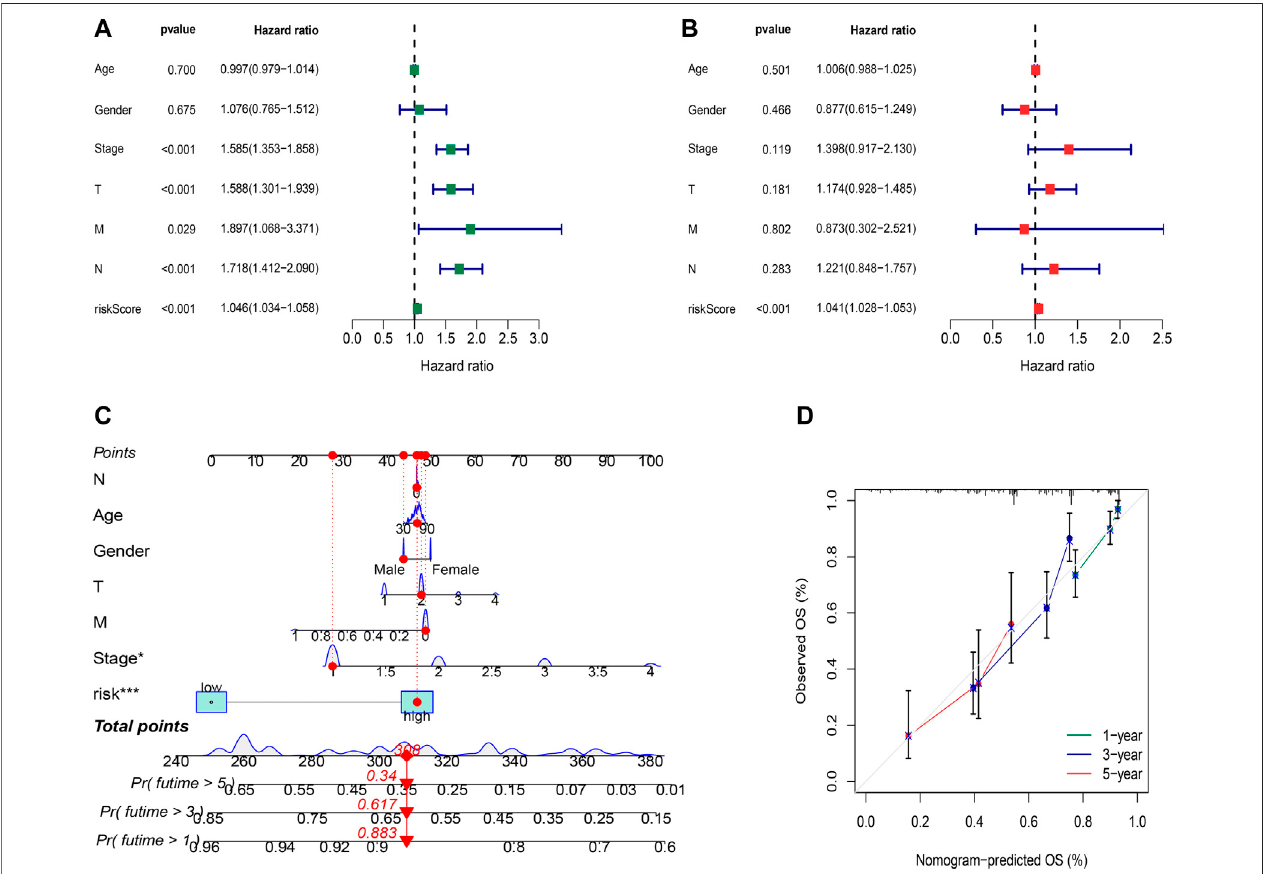
FIGURE 5 | Independent prognostic factors and construction of the nomogram. (A) Univariate analysis of the clinical characteristic and risk score with the OS. (B) MultivariateanalysisoftheclinicalcharacteristicandriskscorewiththeOS. (C) Nomogrampredictstheprobabilityofthe1-,3-,and5-yearOS. (D) Calibrationplotofthe nomogram indicates the probability of the 1-, 3-, and 5-year